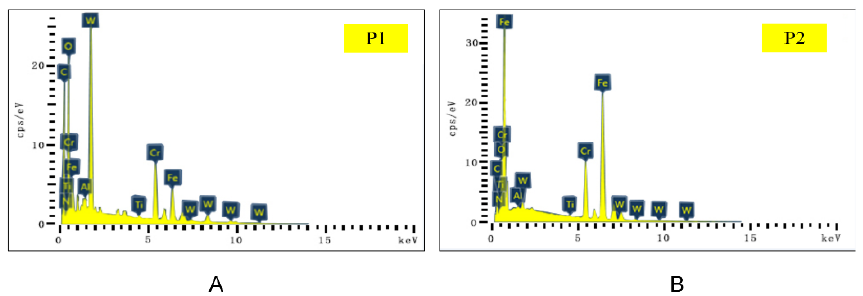
Figure 12. Energy dispersive X-ray spectroscopy (EDS) analysis results of corresponding points P1 ( A ) and P2 ( B ) in Figure 11.